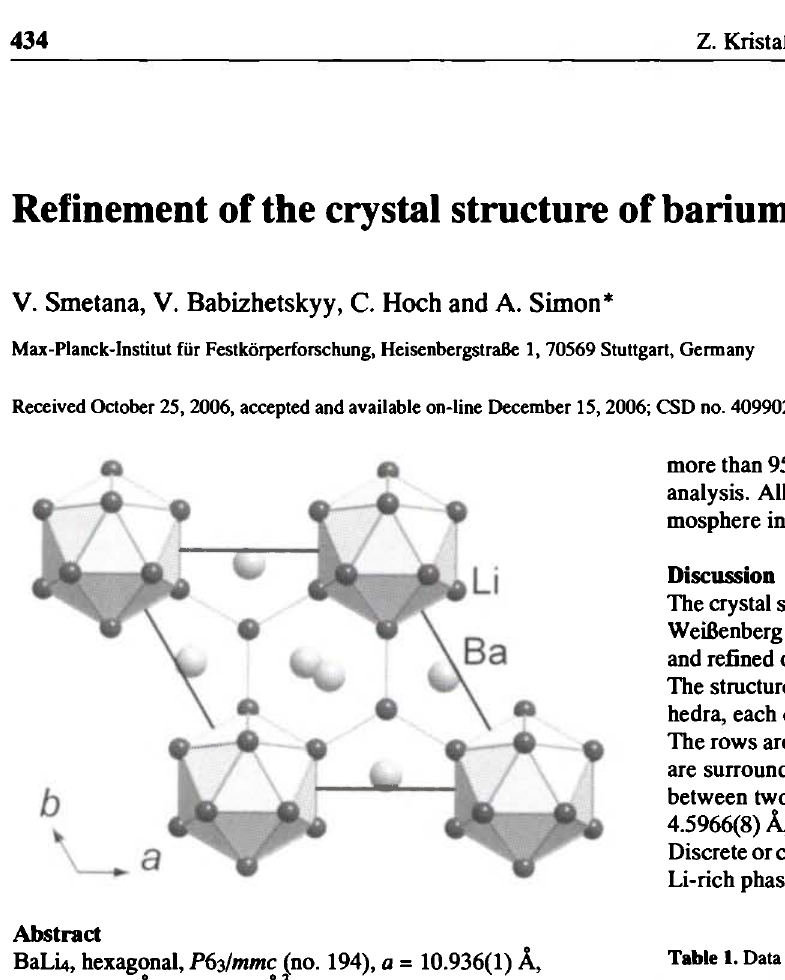
Table I. Data collection and handling.